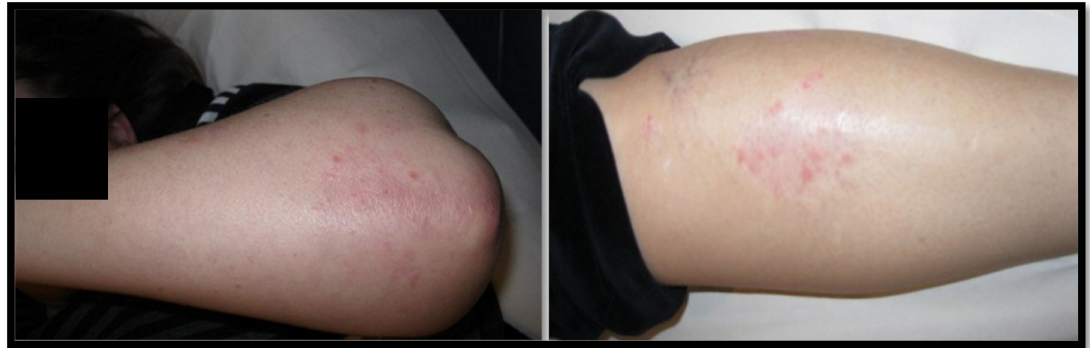
Figure 3. Effect after six sessions of hirudotherapy in the treatment of psoriasis. Source: materials provided by one of the experts (with the consent of the patient).